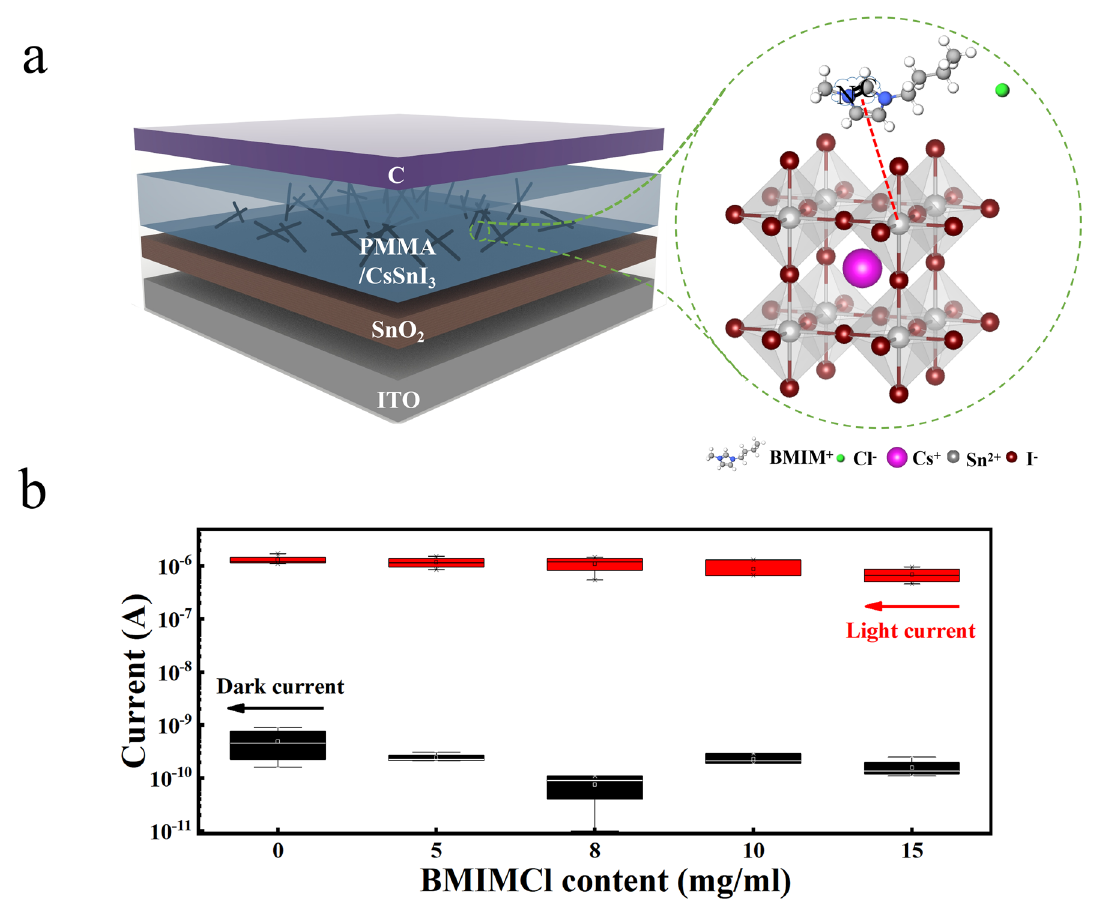
Fig. 2 a Schematic structure of a PD based on the CsSnI 3 with BMIMCl. b Device light/dark current statistic data under the addition of differ- ent levels of